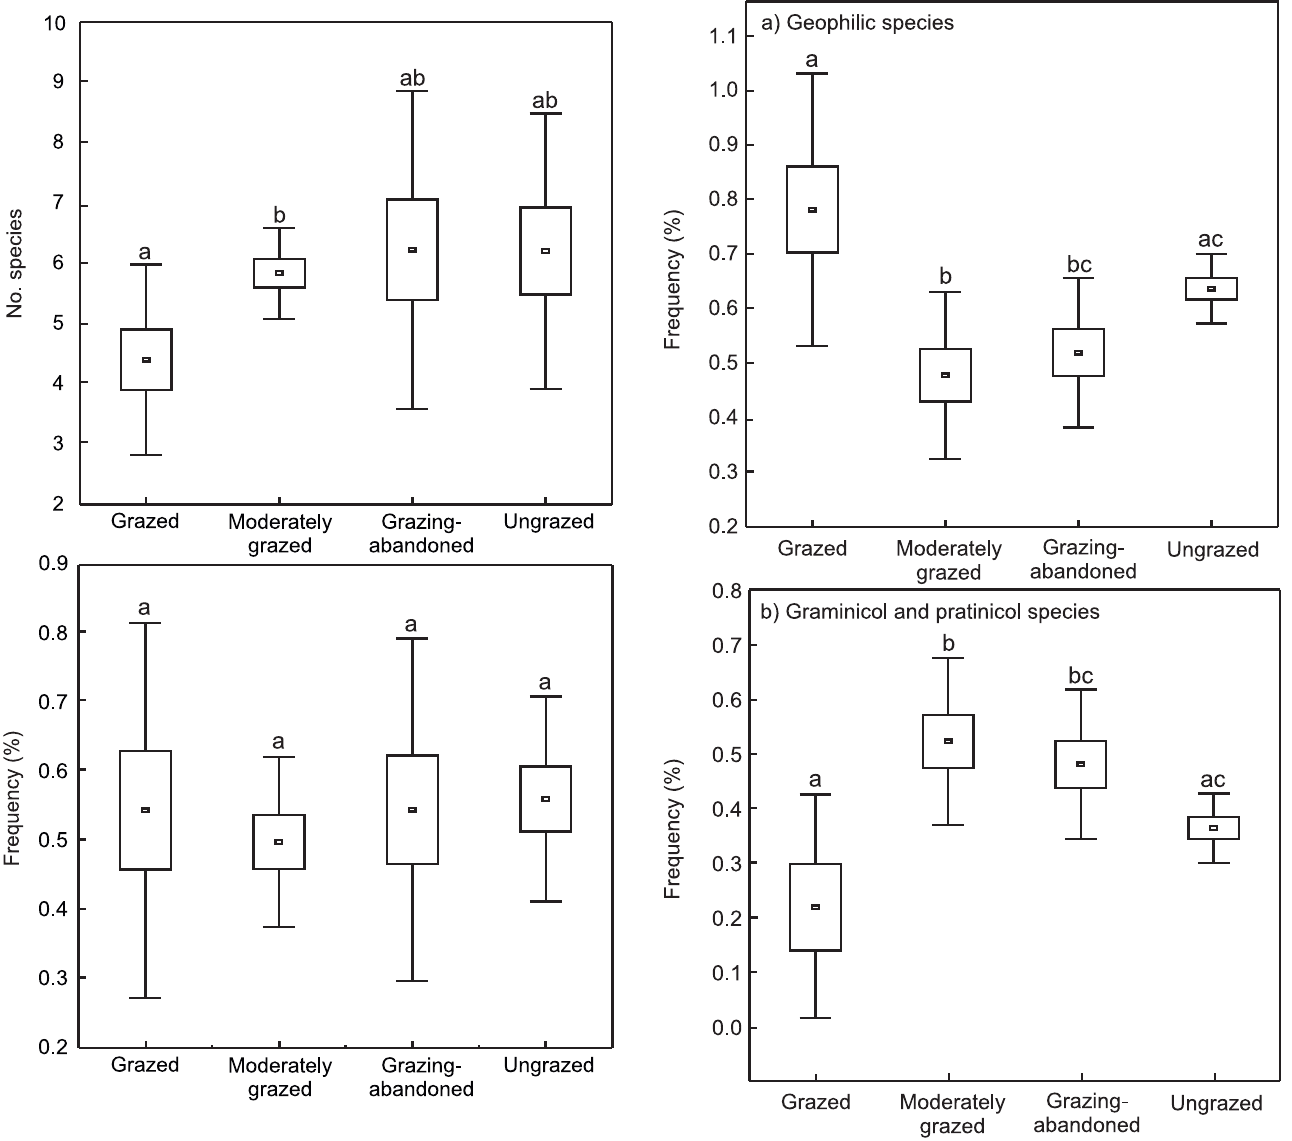
Fig. 4. Mean values (min-max and ±SE) of species number and frequency of habitat specialist species under different grazing pres- sure. Significant (p<0.05) differences detected by Mann-Whitney U test are indicated by different letters.